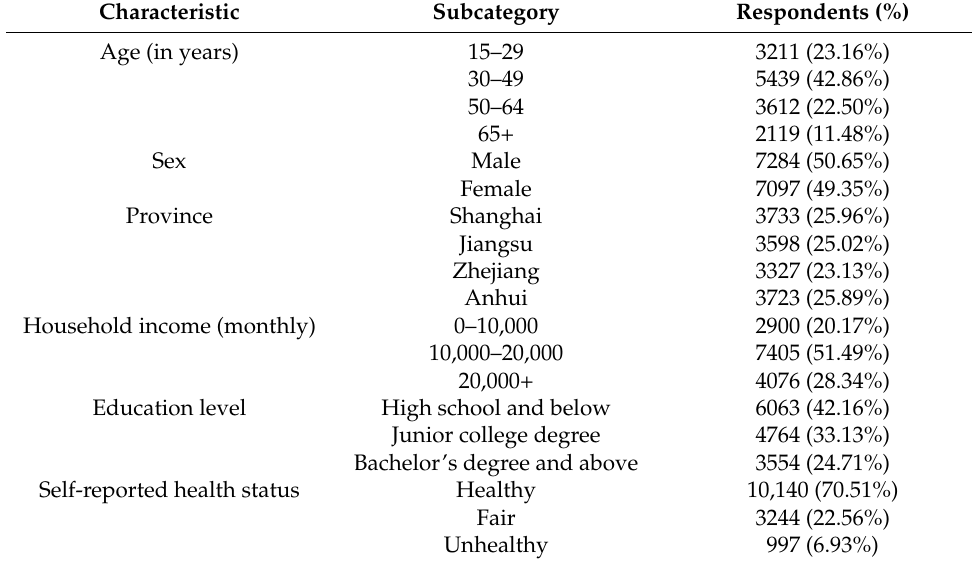
Table 2. Statistics of demographic